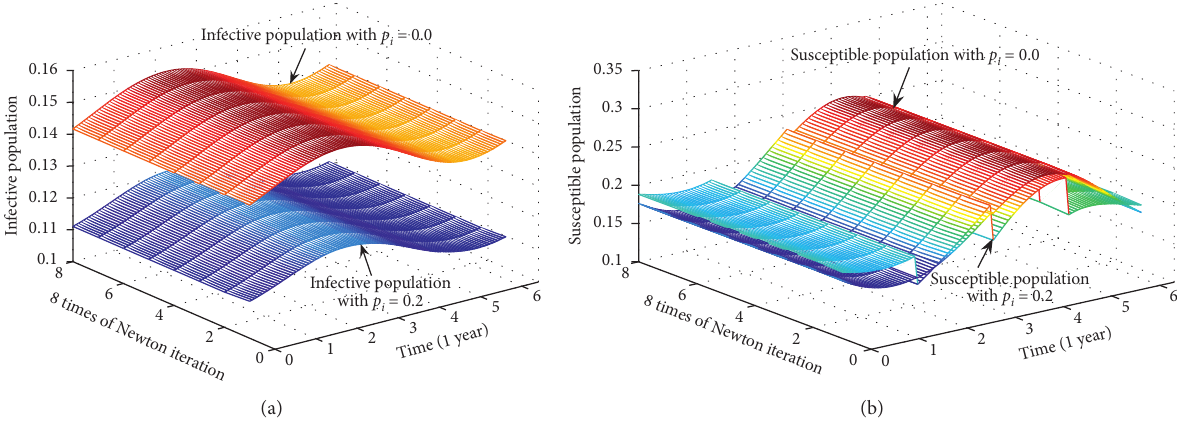
Figure 2: Infective and susceptible population with p